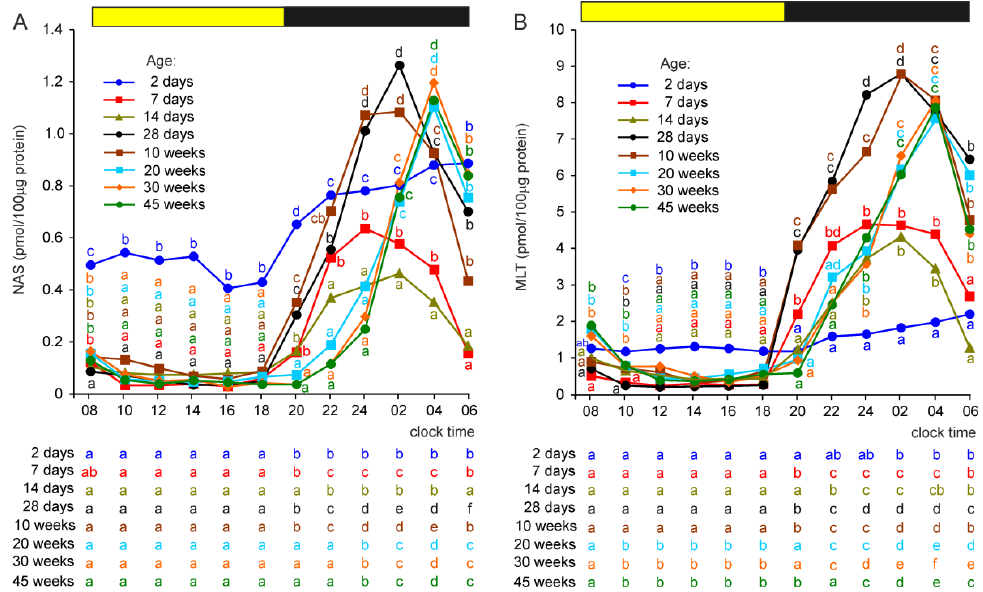
Figure 4. Concentrations (means) of N-acetylserotonin, NAS ( A ), and melatonin, MLT ( B ), in the pineal organs of turkeys at the ages of 2, 7, 14, 28 days and 10, 20, 30, 45 weeks. The horizontal bar represents the periods of light and dark phases of the daily cycle. The letters on the charts show differences between age groups at each time-point in Duncan’s test. The letters below the charts show differences between time-points within a group in Duncan’s test. The same letters indicate means which are not significantly different.